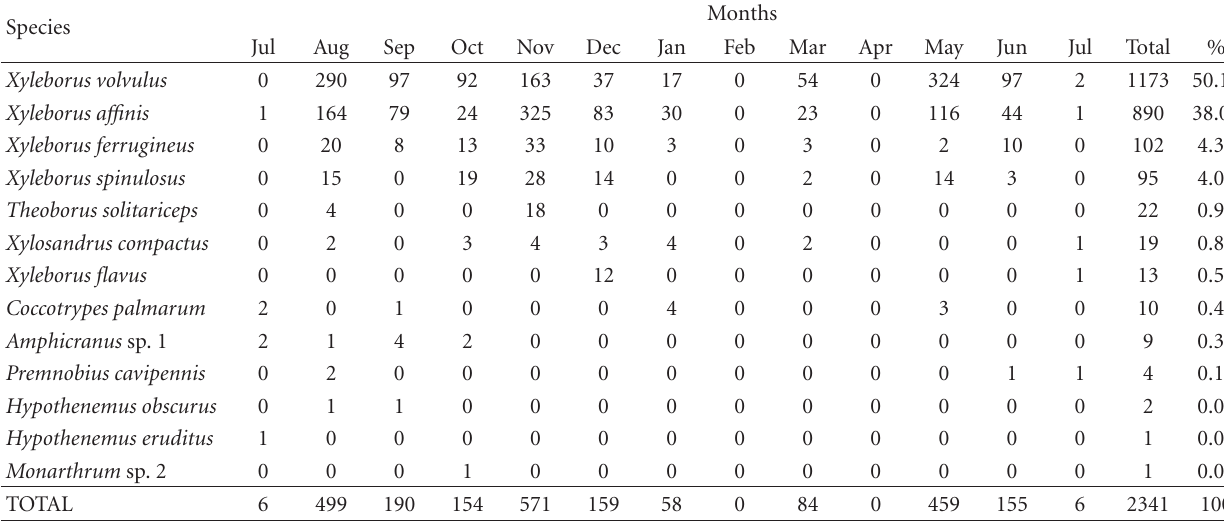
Table 1: Absolute and relative abundance of insects of the subfamily Scolytinae collected with pitfall traps during the period of July 2005 to July 2006, in primary forest of Central Amazon.